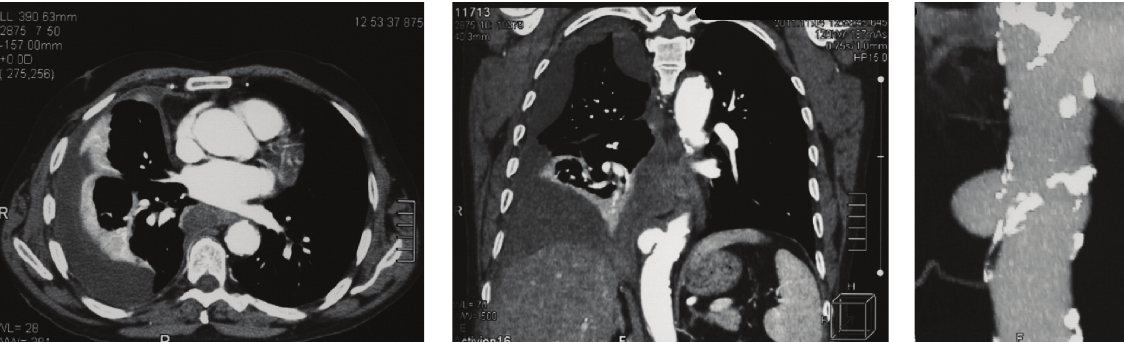
Figure 1: Computed tomographic scan of the chest depicting the right pleural e ff usion along with atelectasis and the saccular aneurysm of the descending aorta.